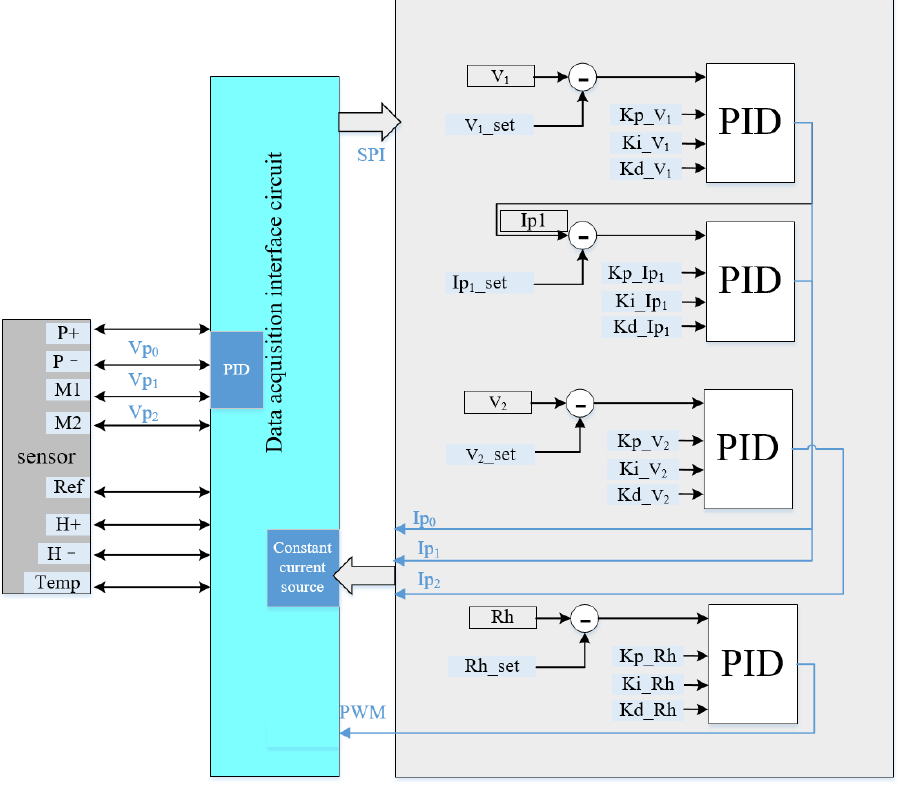
Figure 3. NOx sensor control logic diagram. Table 1. Symbol